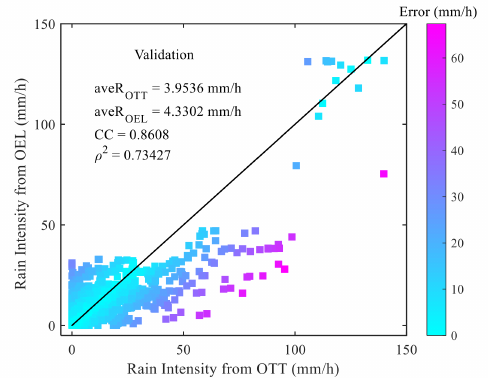
Figure 7. The comparisons of rain intensity between OTT and OEL: the color of each square indicates its corresponding absolute error.